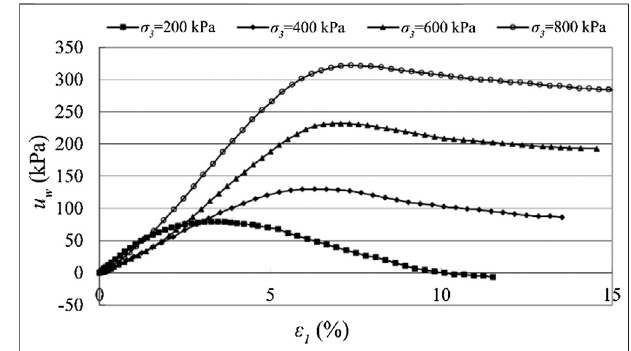
FIGURE 6 | Curves of ( ε 1 ∼ ε v ) of saturated sample under different con fi ning pressures (CD).